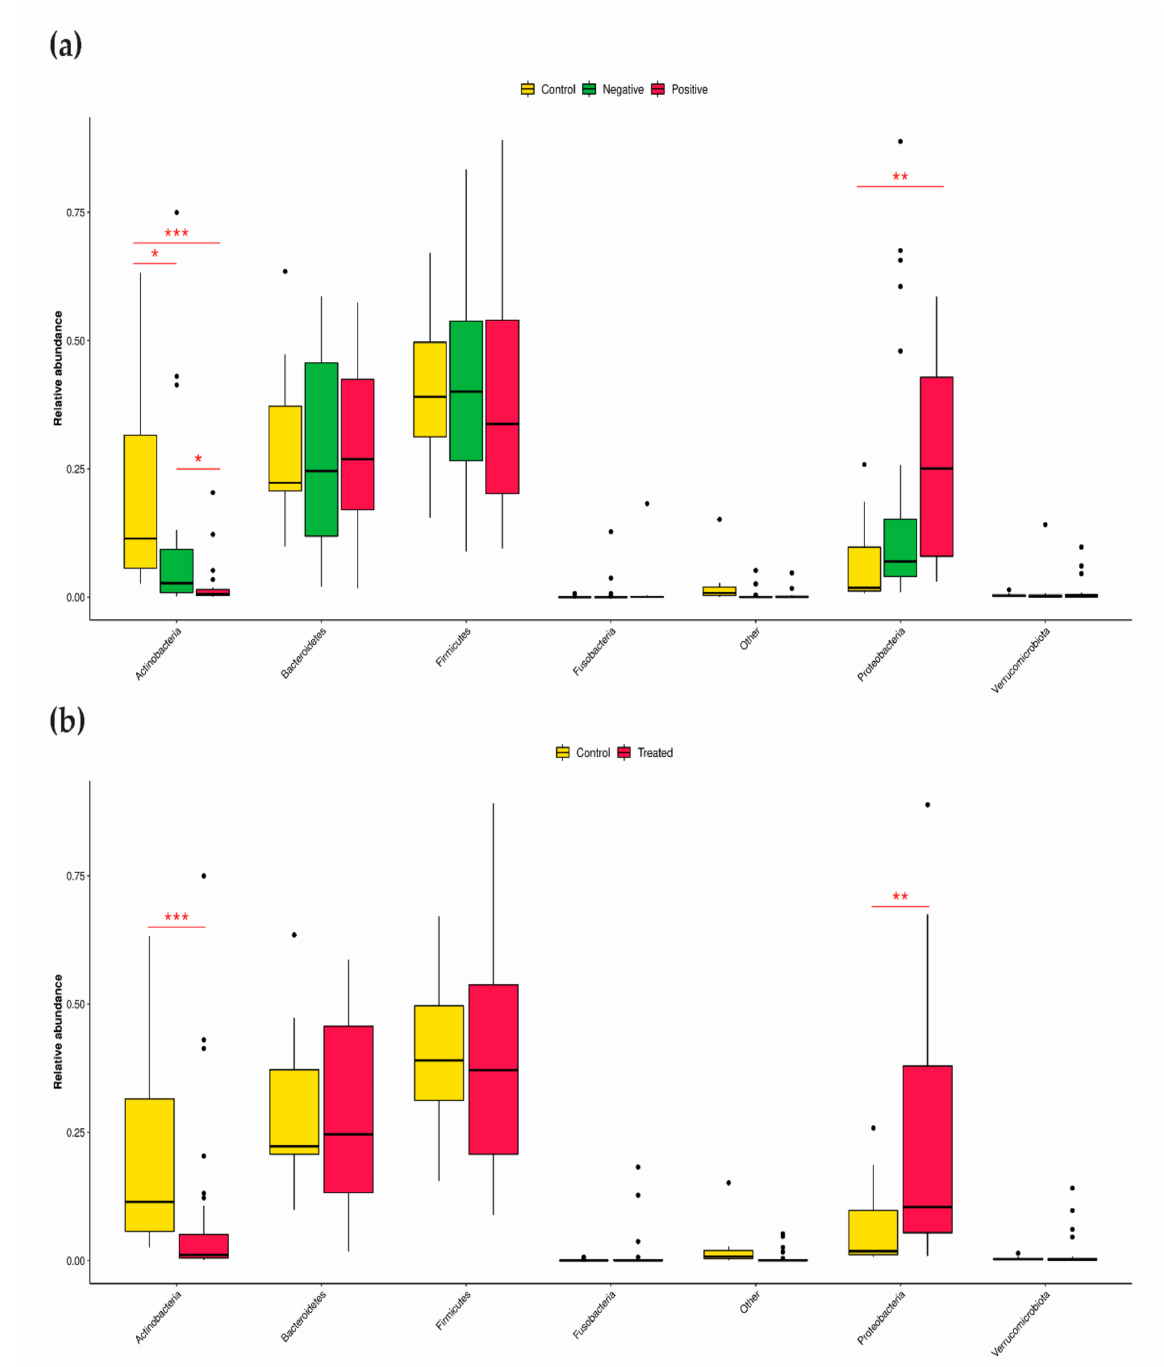
Figure 3. Relative abundance of phyla in the CRE-based and antibiotic regimen-based groups. ( a ) Relative abundance of the top phyla in CRE-based groups. ( b ) Relative abundance of the top phyla in antibiotic regimen-based groups. All taxa with a gene copy number-corrected relative abundance below the respective median were classified as “Other”. Differences in the relative abundance in the CRE-based groups were identified using the Kruskal–Wallis test followed by the Dunn post hoc test. Differences between the antibiotic groups were identified using the Wilcoxon test. An adjusted or nominal p value threshold of 0.05 was used to define statistical significance. * (adjusted) p value < 0.05; ** (adjusted) p value < 0.01; *** (adjusted) p value <